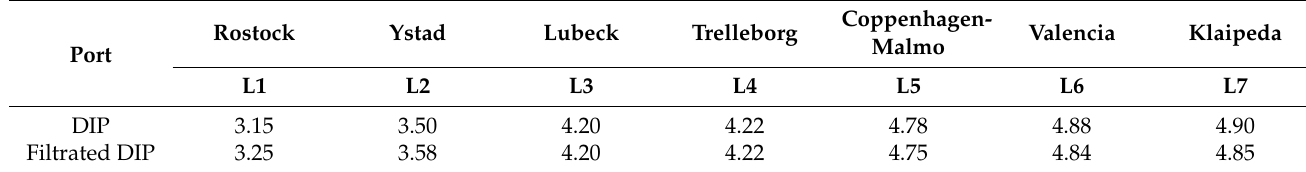
Table 6. DIP score values calculated for large ports.